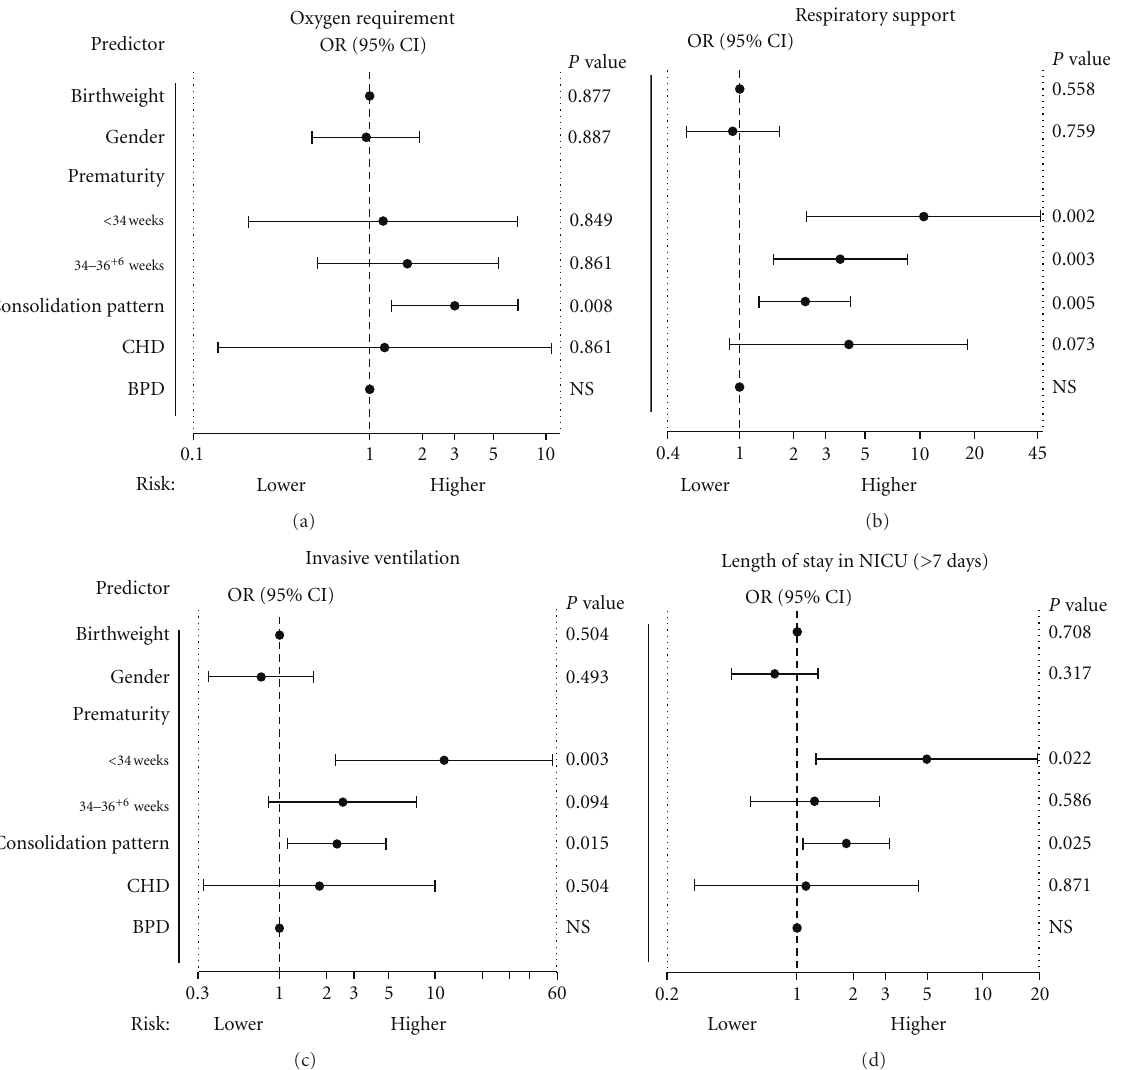
Figure 3: Odds ratios (ORs) for risk factors associated with disease severity in newborns with respiratory syncytial virus hospitalized in neonatal intensive care. According to multiple logistic regression analyses, the independent significant risk factors associated with disease severity, that is length of stay in NICU ( ≤ 7 versus > 7 days), requirement of oxygen, respiratory support and invasive ventilation are those with a P value of < 0.05. The reference category for gender is male, for prematurity ( < 34 and 34–36 +6 weeks) is term ( ≥ 37 weeks) and for consolidation pattern is hyperinflation. NS indicates not